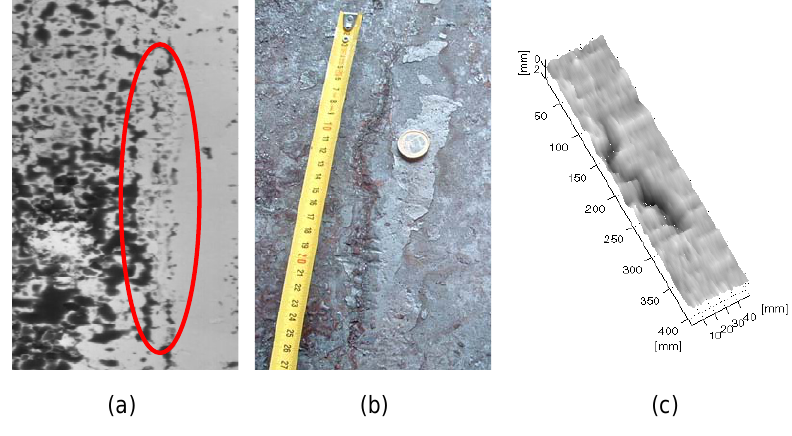
Figure 8. A typical surface crack; (a) shows a gray-level image of the hot slab, where the crack (marked by the ellipse) is hardly visible, (b) shows a picture of the crack once the slab is cold, and (c) shows the distance map obtained with the inspection system over the hot slab. Undulations along the surface are most probably due to vibrations in the slab while it is moved by the rollers (courtesy of